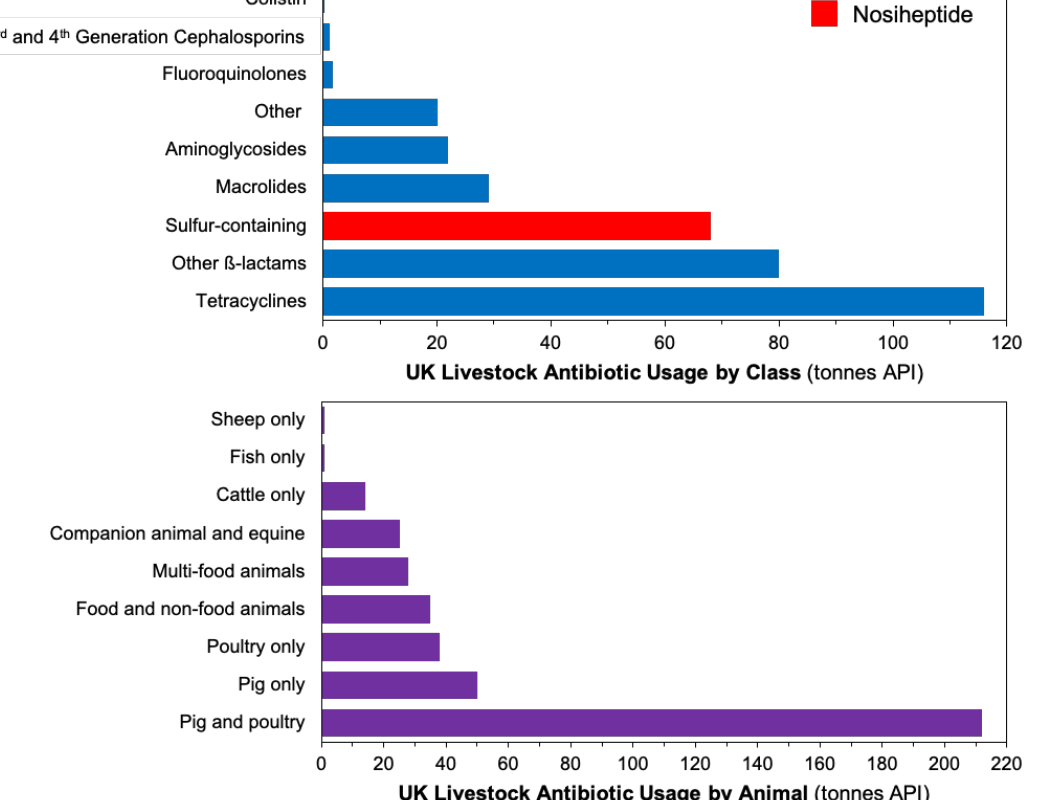
Figure 2. Sales of livestock antibiotics for by antibiotic class (top) and animal type (bottom) [11].